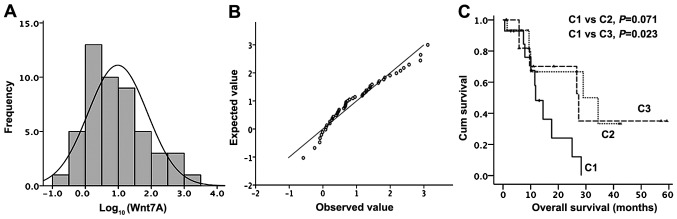
Statistical analysis of Wnt7A expression. (A) Frequency distribution of Wnt7A expression value logarithm. (B) Normal probability plot showing conformity of a normal distribution. (C) The Kaplan-Meier curves plotted for epithelioid tumors showed better prognosis (C1, low Wnt7A; C2, intermediate Wnt7A; C3, high Wnt7A; C1 vs C2, P=0.071; C1 vs C3, P=0.023).